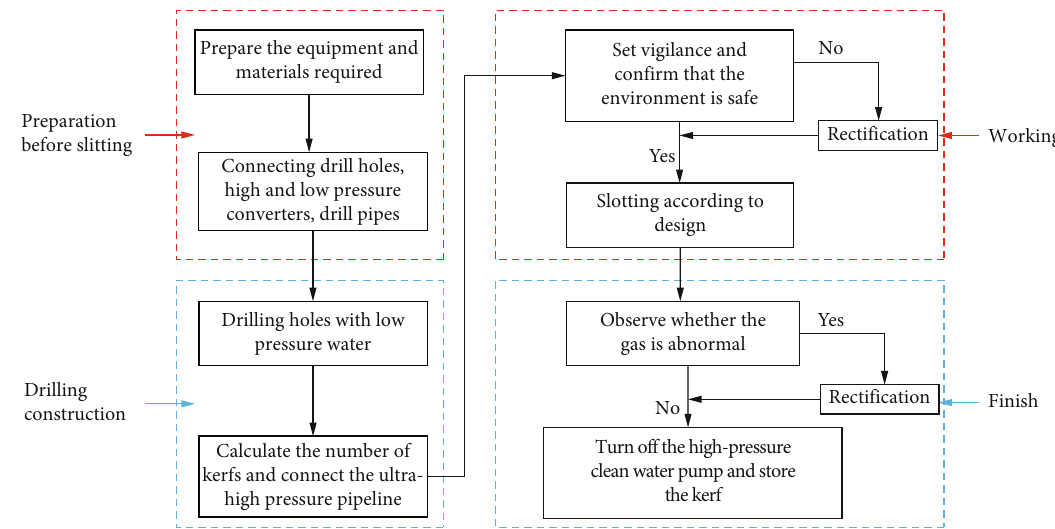
Figure 19: Flow chart of ultra-high-pressure hydraulic kerf